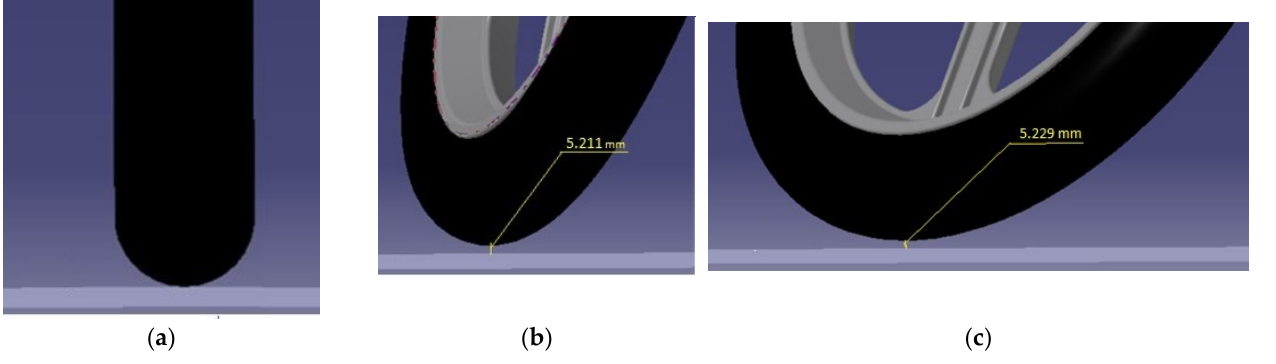
Figure 4. A change of wheel height when turning the steering wheel of the E3-cycle: ( a ) Driving in a straight track; ( b ) A partial front wheel deflection; ( c ) A full front wheel deflection.